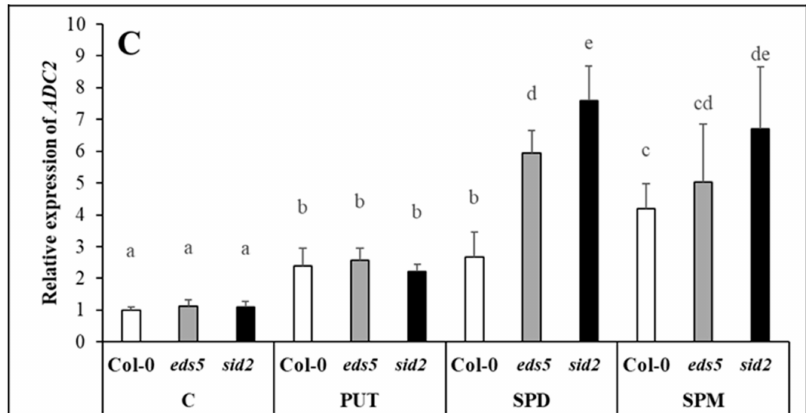
Figure 2. E ff ect of 0.5 mM 1-day of putrescine (PUT), spermidine (SPD) and spermine (SPM) treatments on the endogenous putrescine content (( A ) PUT) and on the expression levels of putrescine synthesis genes ( B , C ) ADC1-2: arginine decarboxylase1-2 ) in Col-0, wild type, eds5-1 ( eds5 ) and sid2-2 ( sid2 ) Arabidopsis mutants. Data represent mean values ± SD. Di ff erent letters indicate significant di ff erences at p ≤ 0.05